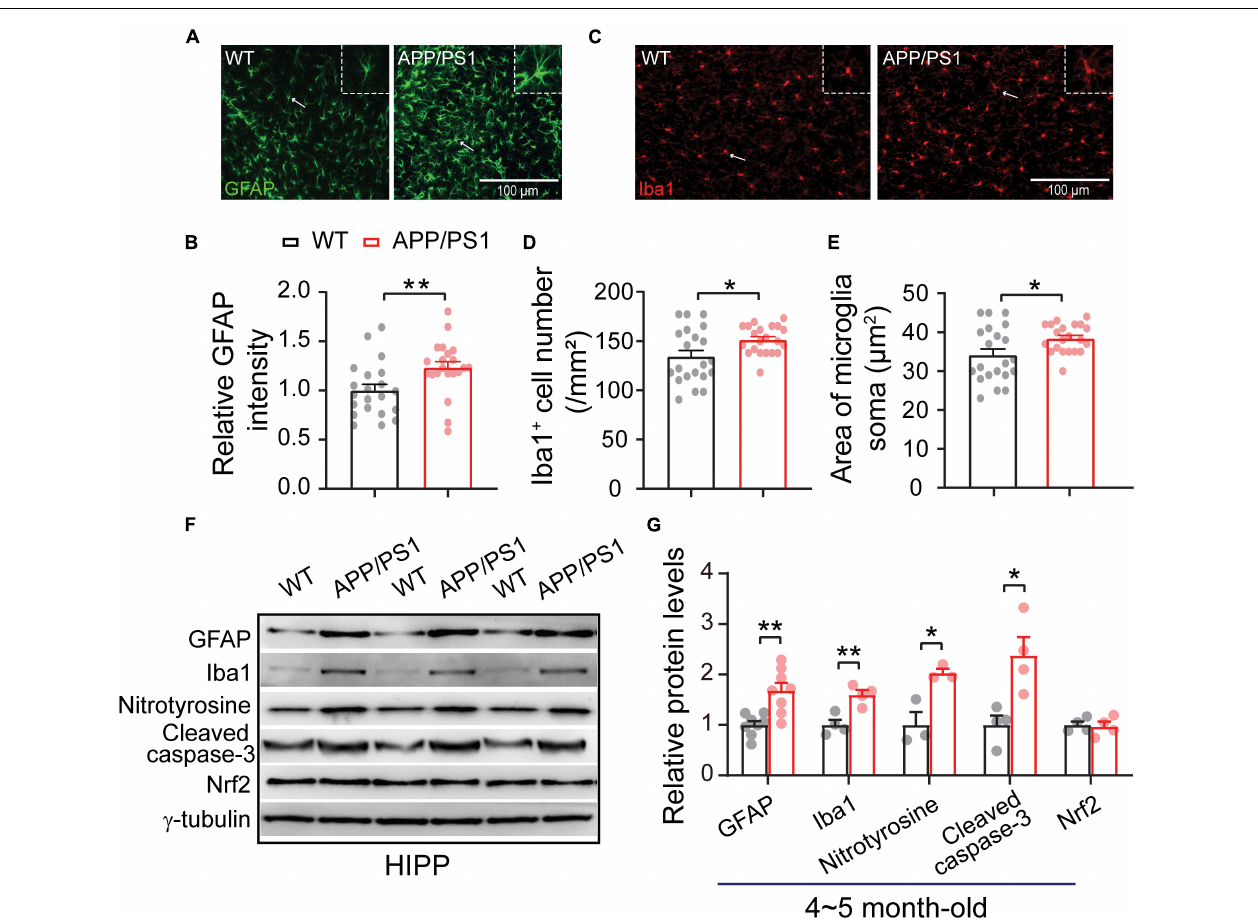
FIGURE 7 | Increased neuroinflammation and oxidative stress in the HIPP of 4 ∼ 5 month-old APP/PS1 mice. (A) Immunofluorescent staining of GFAP in HIPP sections. (B) Increased levels of GFAP in the HIPP of APP/PS1 mice compared to WT mice (7 slices/per mouse, 3 mice per genotype). (C) Immunofluorescent staining of Iba1 in HIPP sections. (D,E) Increased Iba1 + cell number and soma size, showing microglial activation, in the HIPP of APP/PS1 mice compared to WT mice (7 slices/per mouse, 3 mice per genotype). (F,G) Western blotting showing significantly increased levels of GFAP, Iba1, nitrotyrosine, and cleaved caspase-3, but unchanged Nrf2 levels, in the HIPP of APP/PS1 mice compared to WT mice; n = 3–8 mice per genotype; two-sample t -test. Values represent the mean ± SEM, * p < 0.05, ** p <